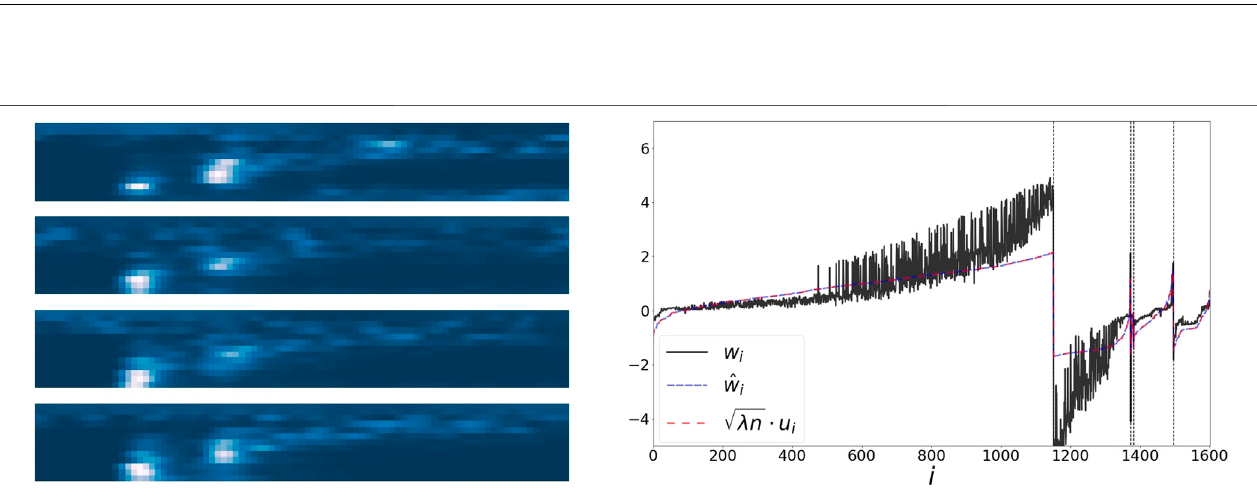
FIGURE 4 | Left: 21 samples from COIL100 dataset. The object is captured at several unorganized angles. Right: The sorted values of the representations w , (cid:13) w and u ,alongwiththecorrespondingobject.Here,therepresentationcorrelateswiththeangleoftheobject.In Figure7 ,wepresentascatterplotcomparingthevaluesof (cid:12)(cid:12)(cid:12) √ (cid:13) w and λ n u .